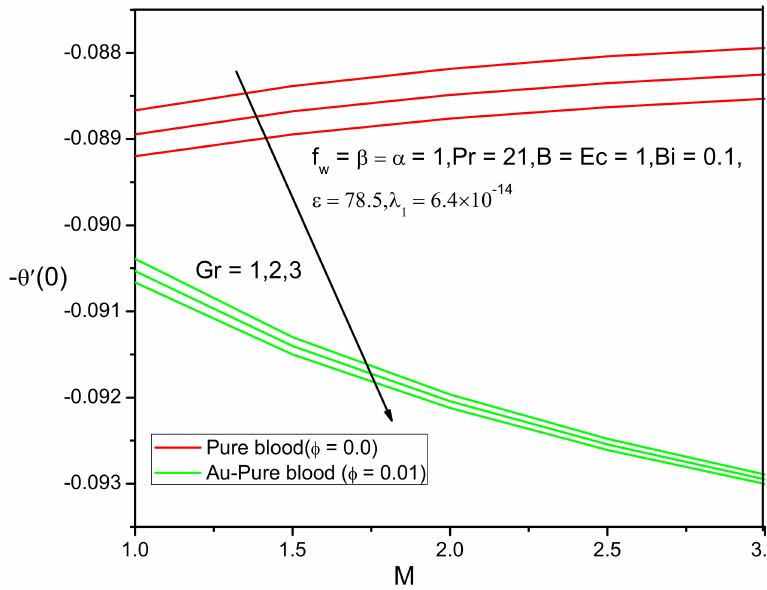
Figure 22. Local Nusselt number − θ (cid:48) ( 0 ) with M for different values of Gr .